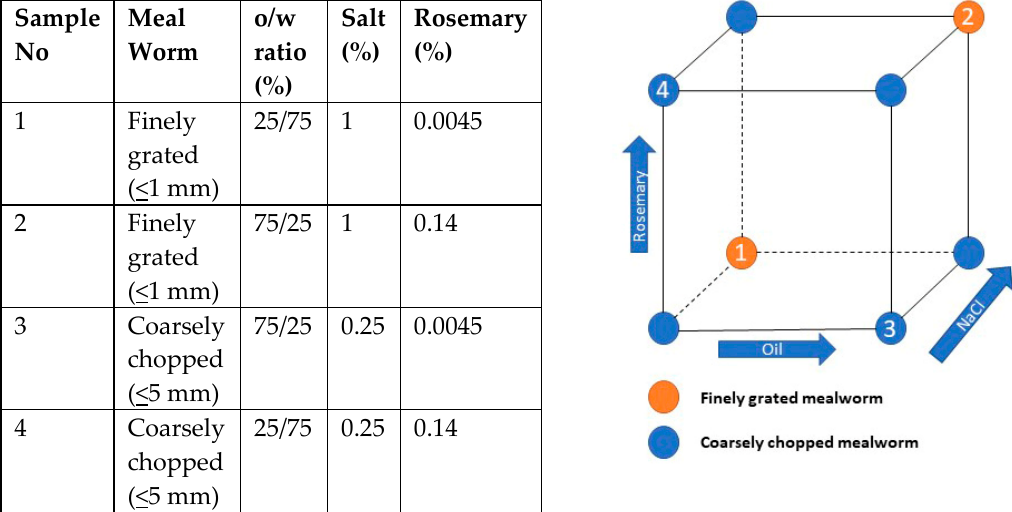
Figure 1. Illustration of the experimental design. To the left an overview of the design and to the right an illustration of the design oil content ~12.5% or ~37.5%, NaCl content ~0.25% or ~1%, and rosemary content ~0.0045% or ~0.14%.